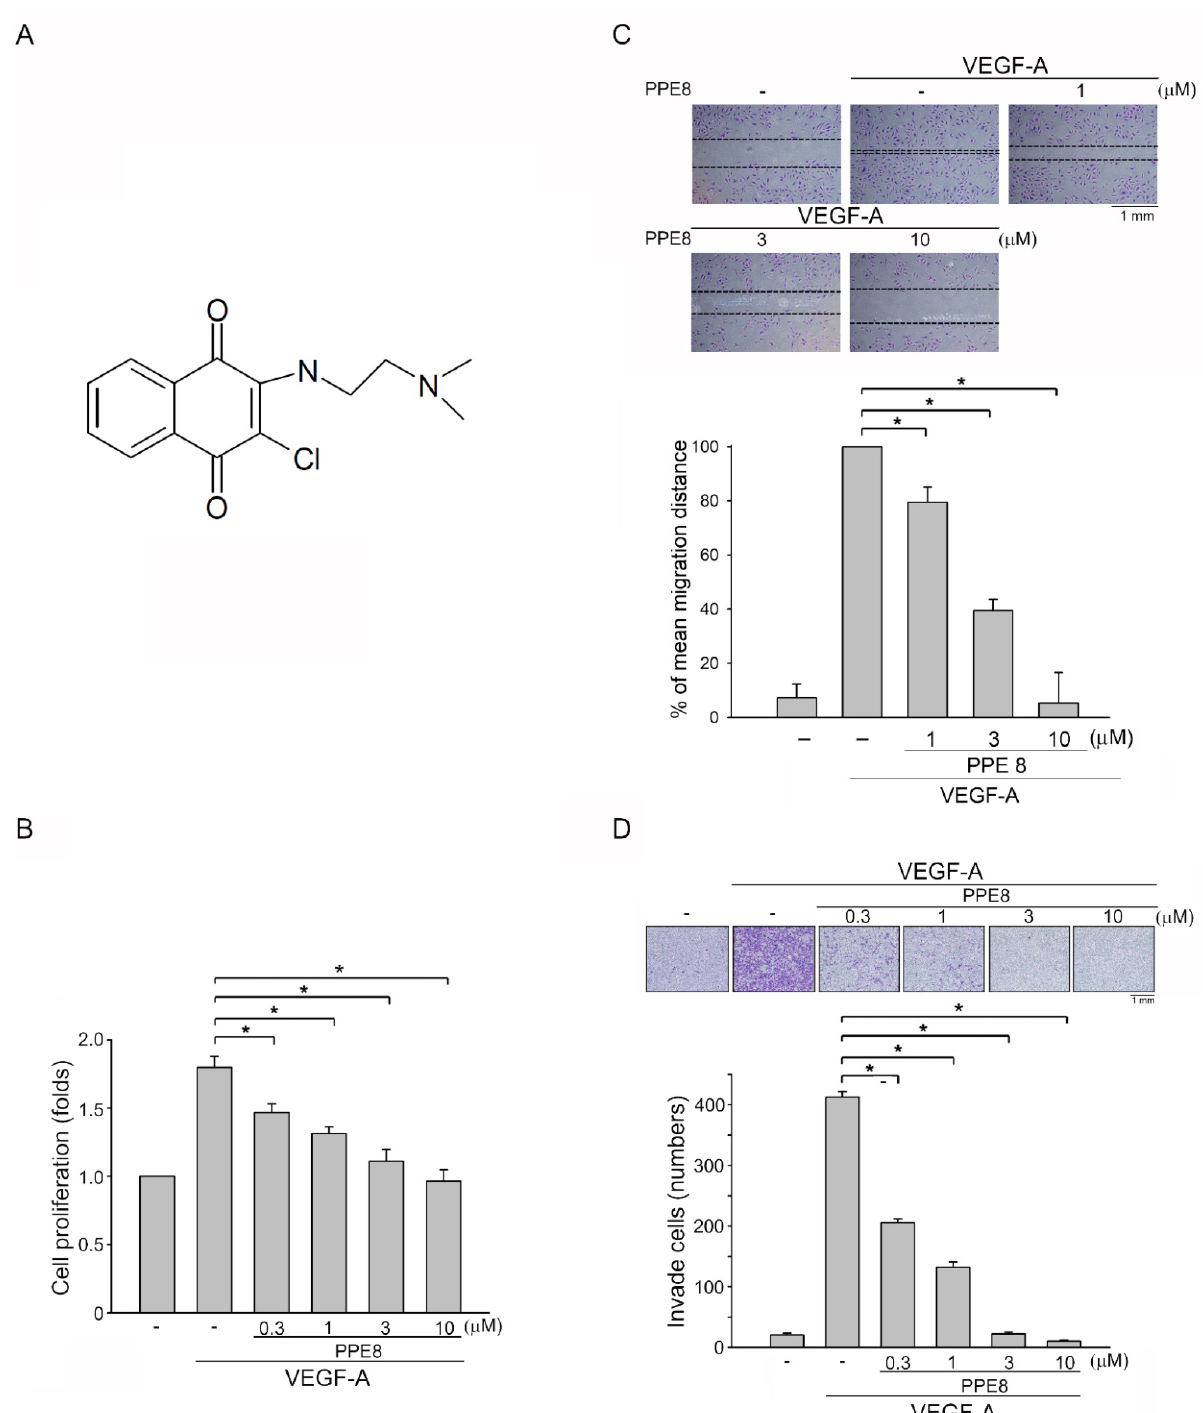
Figure 1. PPE8 suppressed HUVEC migration, invasion, and proliferation after VEGF-A exposure. ( A ) Chemical structure of PPE8. ( B ) After starvation for 18 h with M199 medium containing 2% FBS in the absence of ECGS, HUVECs were pre-treated with PPE8 for 30 min. Cells were then stimulated with VEGF-A (25 ng/mL) for another 24 h. A BrdU-based cell proliferation assay was used to determine cell proliferation. Each column represents the mean ± S.E.M. of six independent experiments performed in duplicate. * p < 0.05, compared with the group treated with VEGF-A alone; Kruskal–Wallis test. ( C ) HUVECs were starved as described in ( B ). HUVECs were scratched and